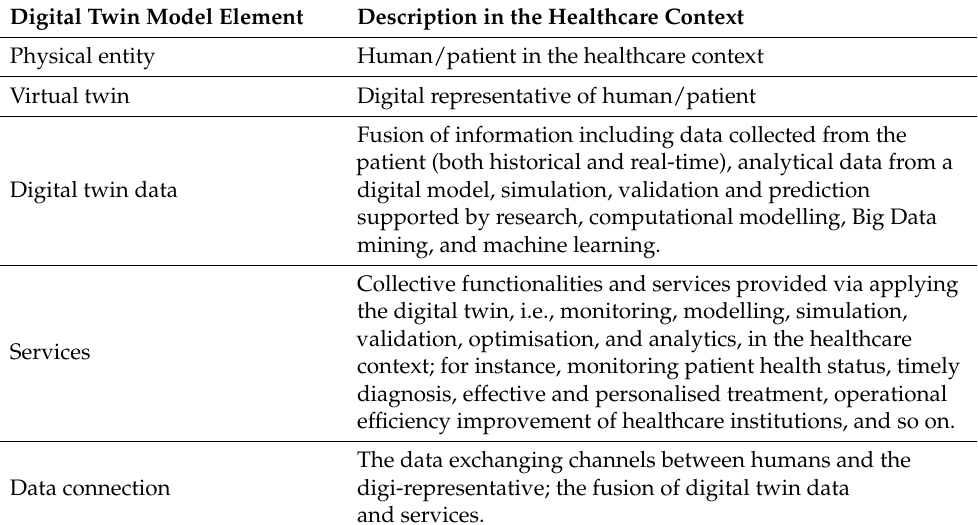
Table 2. Five dimensions of the digital twin model in healthcare.